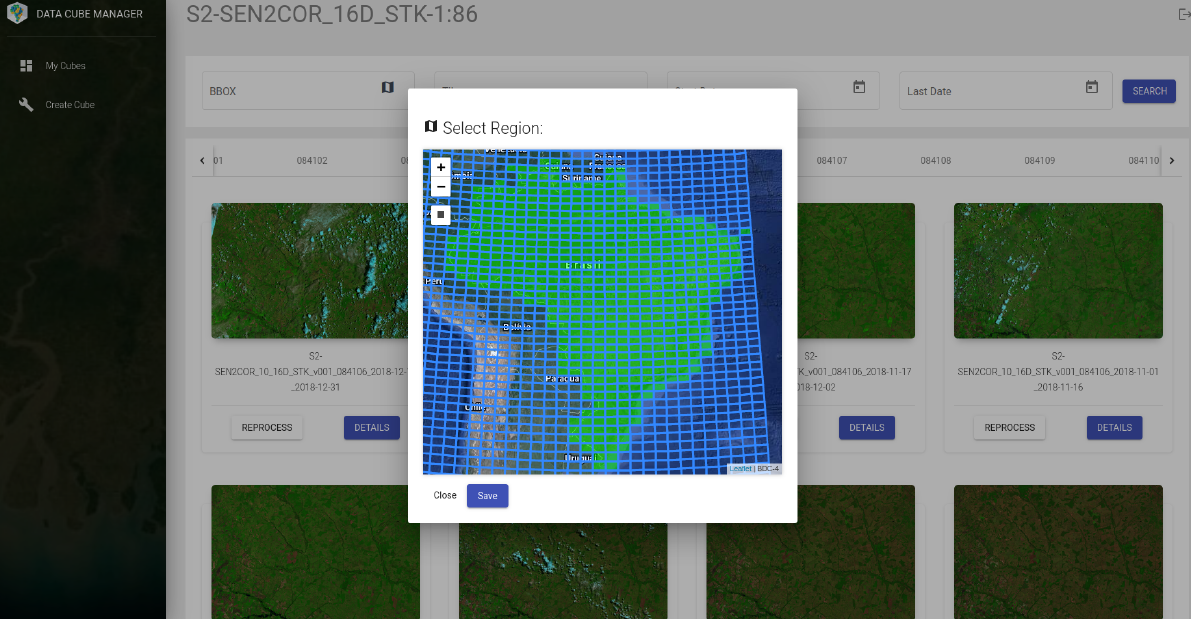
Figure 8. Graphical interface of Data Cube Builder on AWS - Data Cube